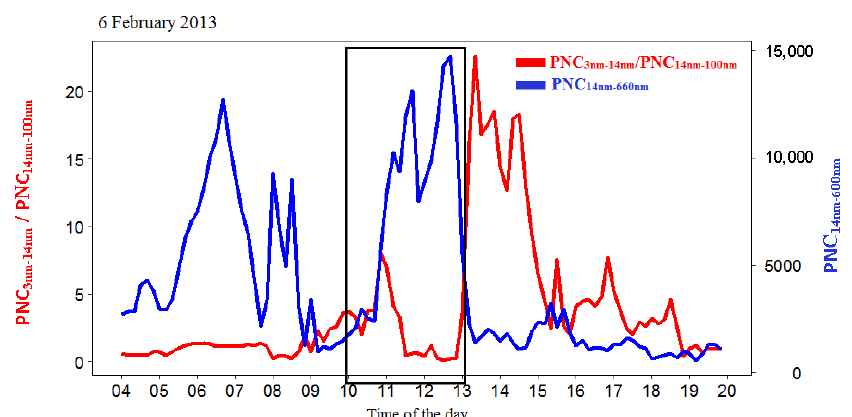
Figure 10. Time series of the total particle number between 14 nm and 660 nm (PNC 14nm–660nm ) and the PNC 3nm–14nm /PNC 14nm–100nm ratio on 6 February 2013. The black rectangular box highlights the growth period. Five-minute averaged data were used in these plots.